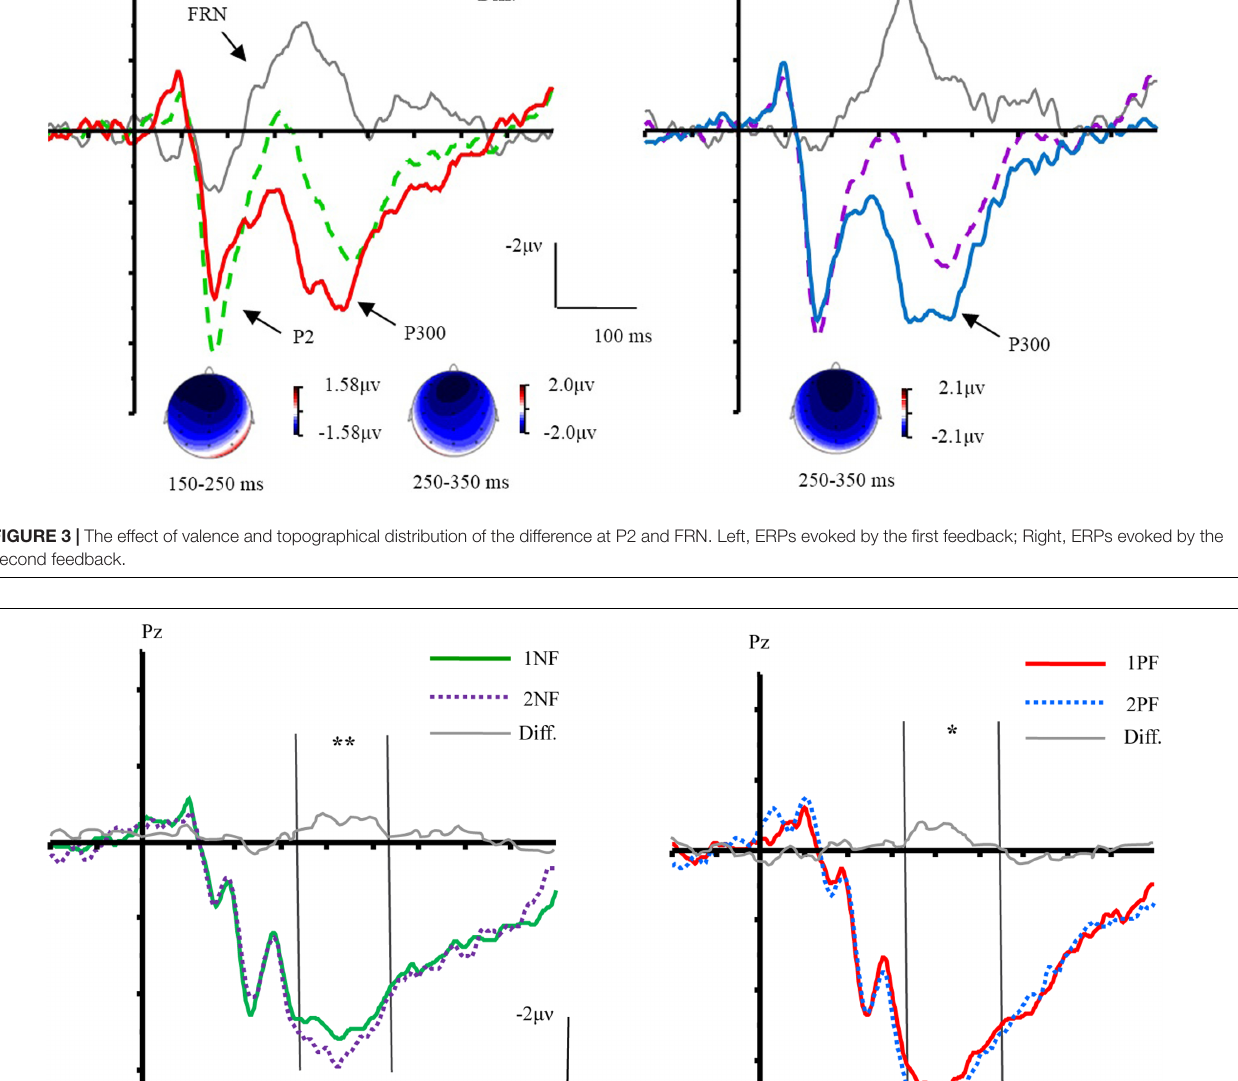
[ F (1,17) = 6.37, p < 0.05, η 2 and order [ F (1,17) = 9.01, p < 0.01, η 2 = 0.27]. A 3-way interaction of p order × valence × laterality was significant [ F (2,34) = 5.41, There was no other interaction effect. Over the middle area, the main effect of valence [ F (1,17) = 10.04, p < 0.01, η 2 p < 0.05, η 2 = 0.24]. Further analyses were conducted by p performing a 2 order (first, second) × 2 valence (positive, and order [ F (1,17) = 6.03, p < 0.05, η 2 negative) ANOVA with repeated measurements over the left, There was no interaction effect. Over the right area, results middle, and right areas, respectively. Over the left area, the main effect of valence [ F (1,17) = 12.60, p < 0.01, η 2 = 0.43] p